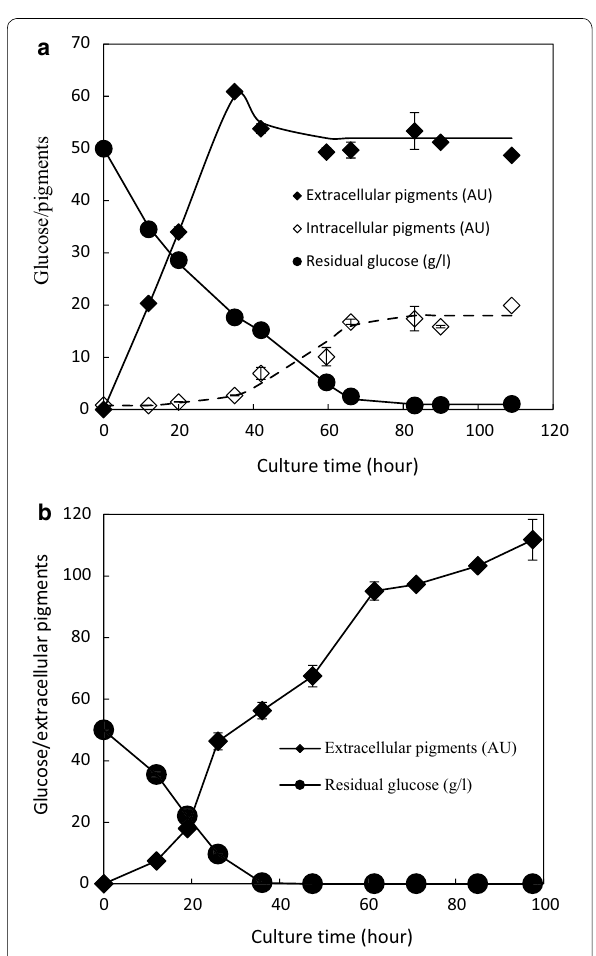
Fig. 3 Time course of cell suspension culture. a In nonionic sur- factant micelle aqueous solution with Triton X-100 70 g. Initial mycelia loading was 10 g lipid-free DCW per liter of the basic medium; b in peanut oil–water two-phase system with volume ratio of oil to water was 1:1. Initial mycelia loading was 12 g lipid-free DCW per liter of the basic medium. Mycelia were collected from extractive fermentation with glucose 35 g/l, MSG 5 g/l, and pH 2.5 (entry 5 in Table 1) at the 6th